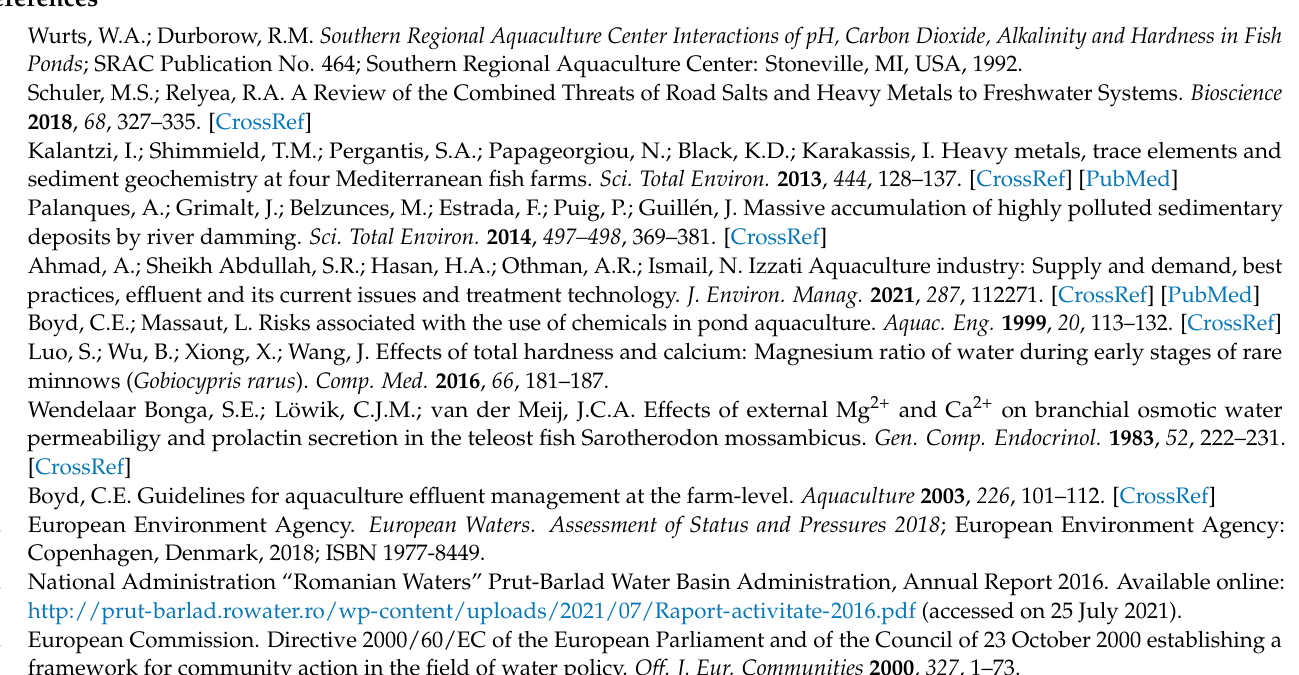
Figure S1: Linear regression between ( ∑ cations − ∑ identified anions) and ([Mg 2+ ] + [Ca 2+ ]) for water samples (a) and sediment (b) samples in both sampling sessions, Figure S2: Linear regression for the ionic balance evaluation of water (a) and sediment (b) samples (including the HCO 3 − estimation), Figure S3: Spatial distribution of K + , NO 2 − , H 3 C 2 O 2 − , and HCO 2 − in water and sediment of Podu Iloaiei Dam Lake, Figure S4: Spatial distribution of water-soluble Al, Ge, Ag, and Sb in water and sediment of Podu Iloaiei Dam